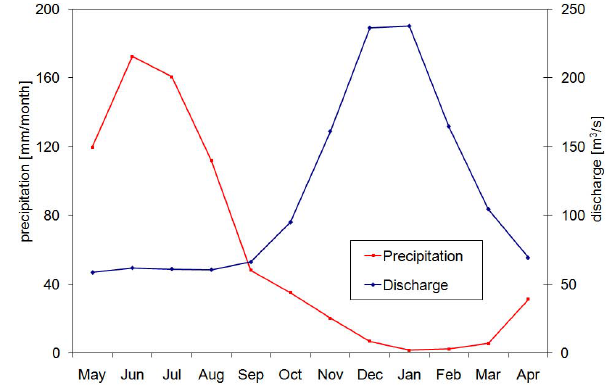
Fig. 2. Seasonal evolution of monthly precipitation and monthly mean discharge in Maipo at El Manzano